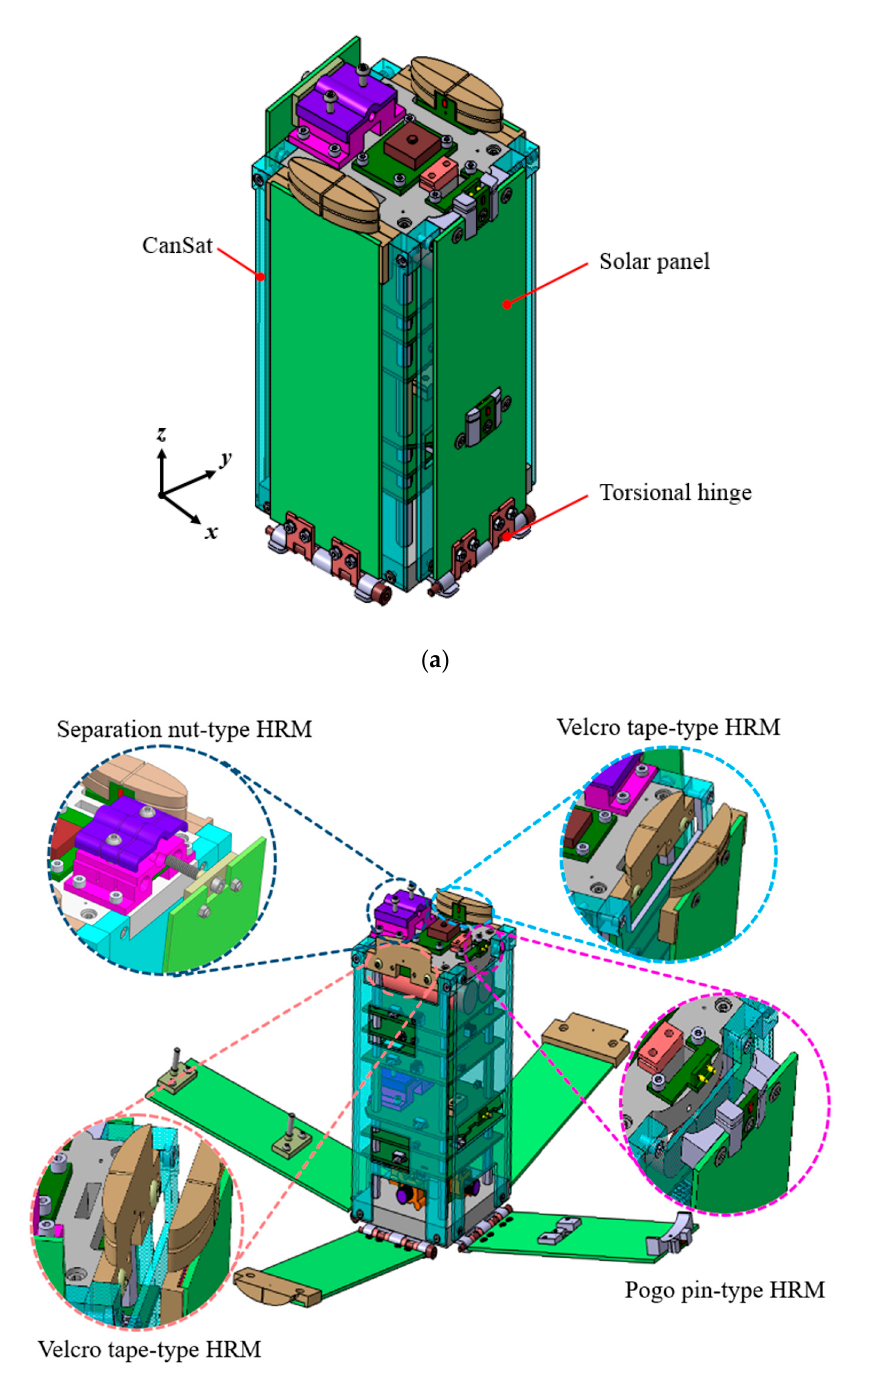
Figure 3. Mechanical configurations of the DHRM CanSat illustrating the solar panels in the ( a ) stowed and ( b ) deployed states.